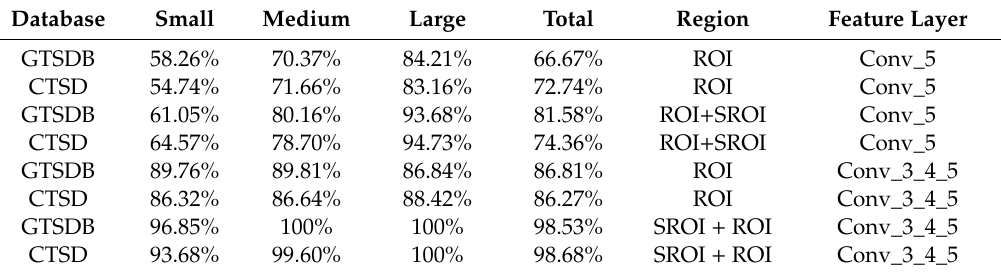
Table 4. The comparison of the detection accuracy with or without the information of secondary regions of interest (SROIs) and multi-layer deep convolution features.